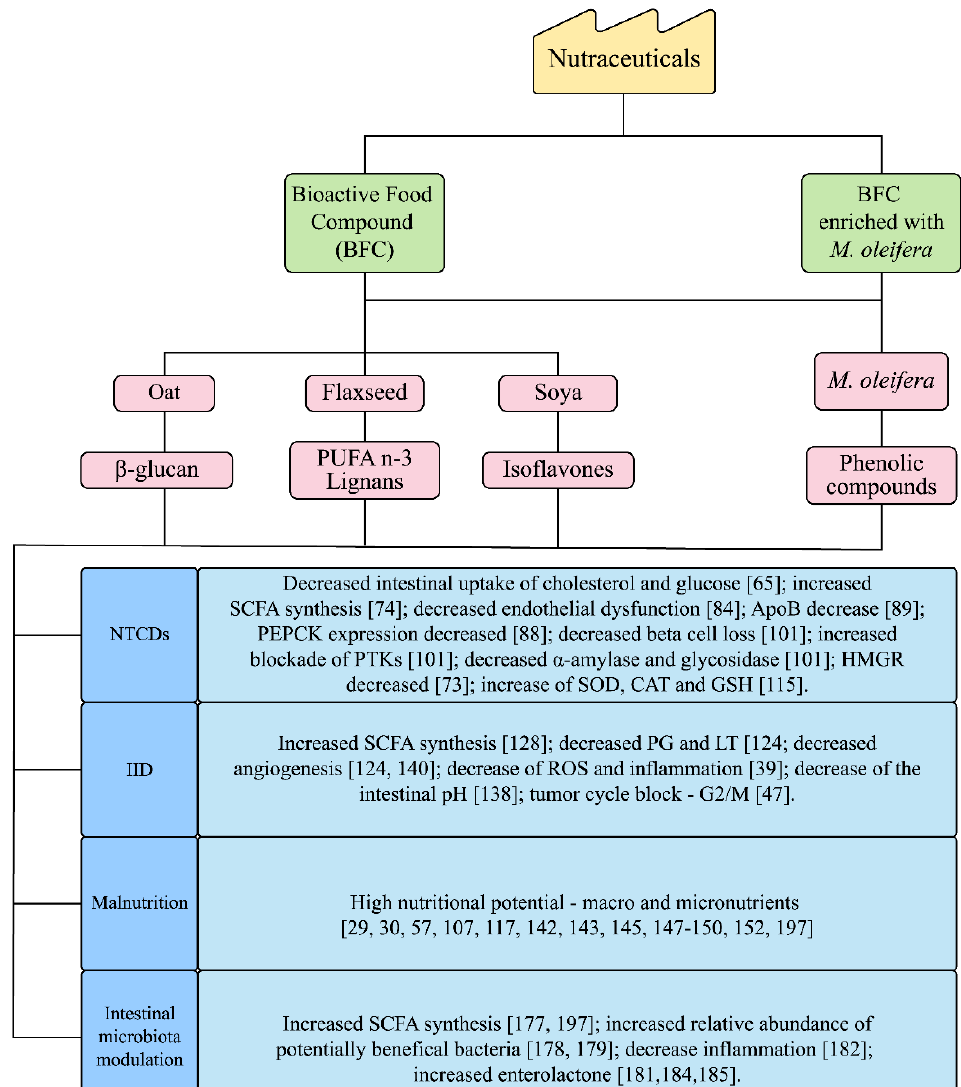
Figure 2. BFCs and M. oleifera physiological and metabolic effects proposed. Short-chain fatty acids (SCFA); Apolipoprotein B (ApoB); Phosphoenolpyruvate carboxykinase (PEPCK); Tyrosine kinase (PTKs); 3- hydroxy-3-methyl-glutaric-CoA reductase (HMGR); Superoxide dismutase (SOD); Catalase (CAT); Glutathione peroxidase (GSH); Prostaglandins (PG); Leukotrienes (LT); and Reactive oxygen species (ROS).